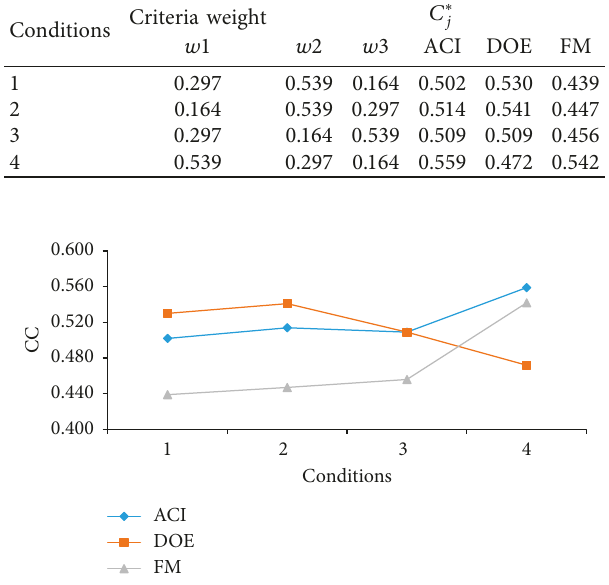
Figure 2: Sensitivity analysis with respect to mix objective